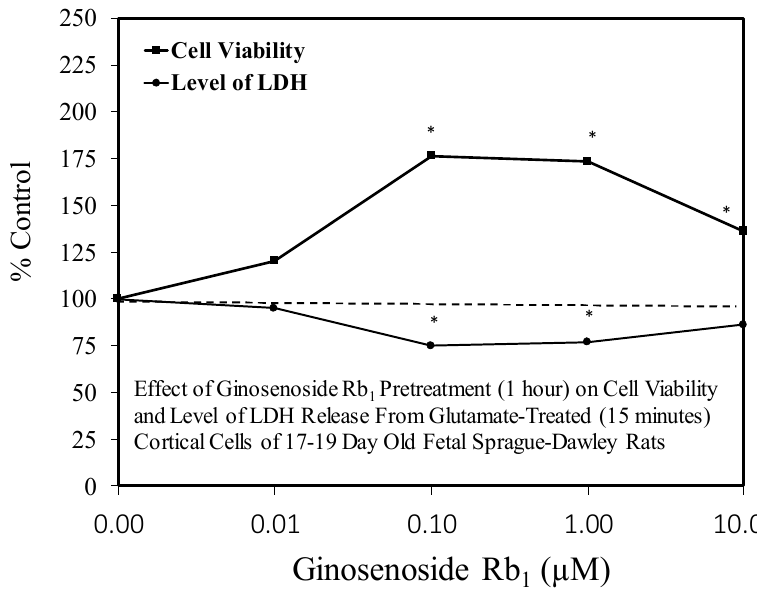
Figure 14. Effect of ginosenoside Rb 1 pretreatment (1 h) on cell viability and level of LDH release from glutamate-treated (15 min cortical cells of 17–19-day-old fetal Sprague–Dawley rats (source: [68]). Each * represent statistical significance for a data point.